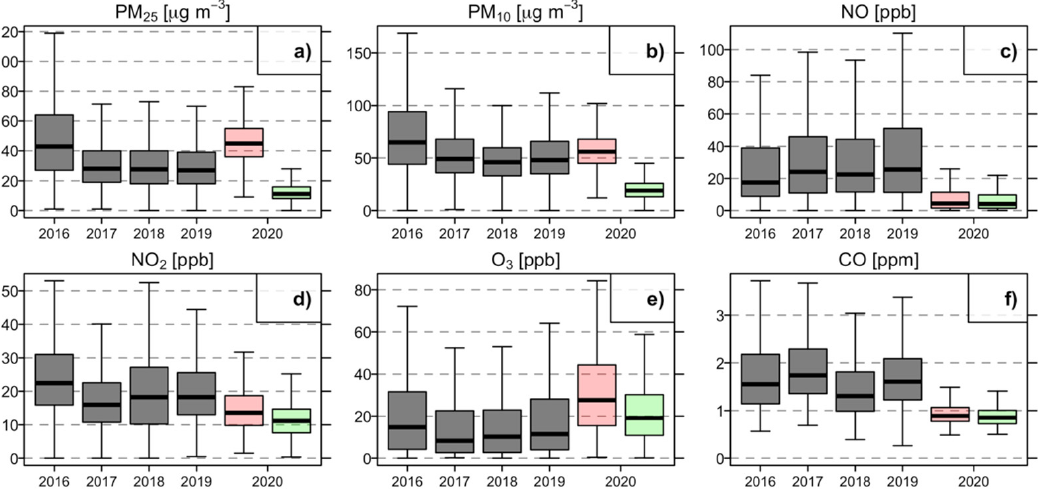
Figure 4. Boxplots for ( a ) PM 2.5 , ( b ) PM 10 , ( c ) NO, ( d ) NO 2 , ( e ) O 3 , and ( f ) CO during the 2016–2019 March–April reference period (gray) and the Lockdown (green) and Fire (red) periods.